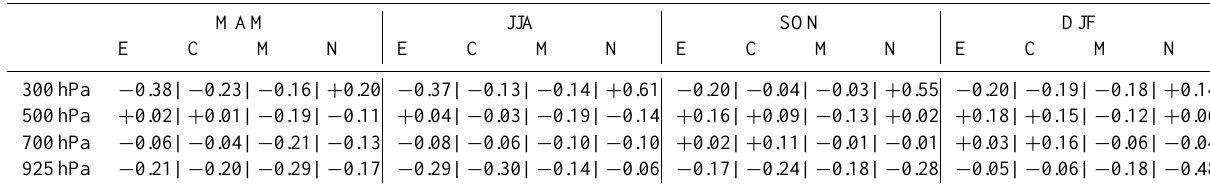
Table 2. Same as Table 1, except for mean bias of seasonal and 70–90 ◦ N average temperature of each reanalysis product, relative to the IGRA data, in units of K. MAM JJA SON